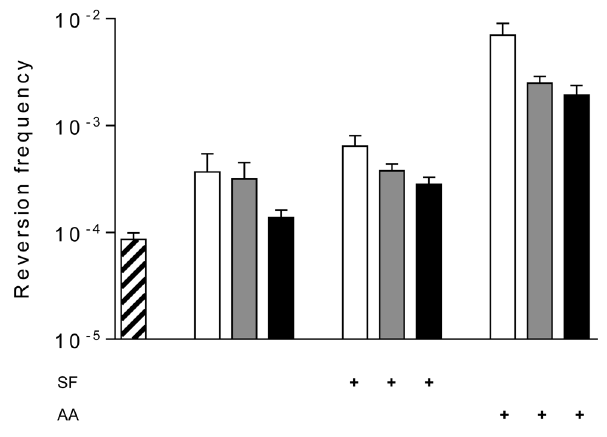
Figure 5. Effect of sinefungin and 5’-amino-5’-